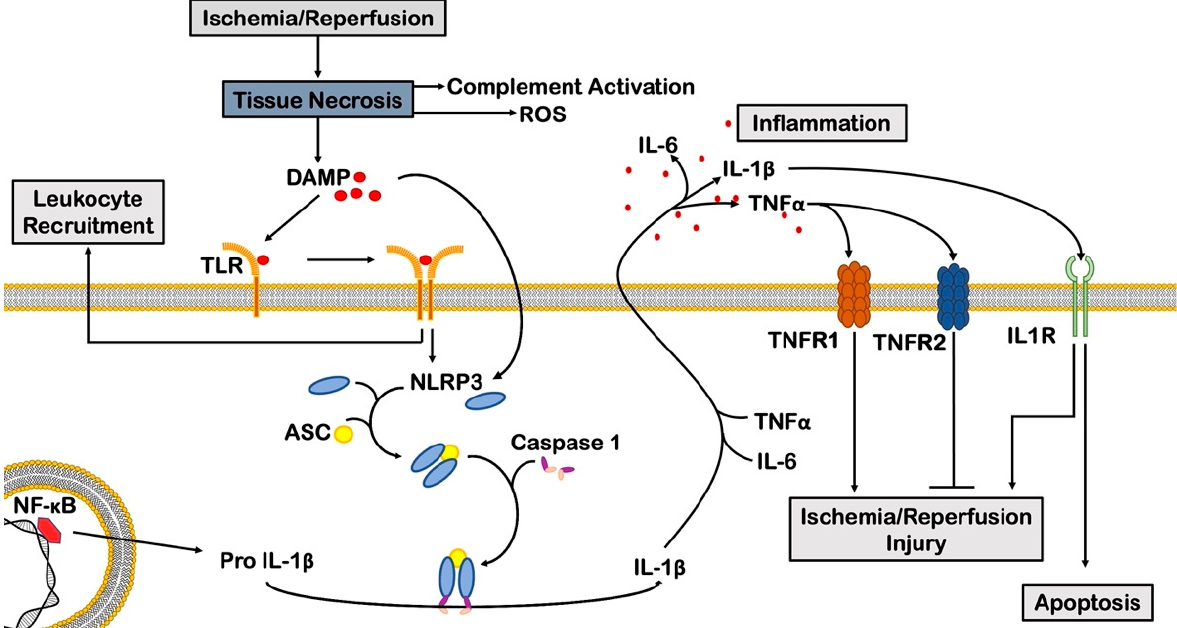
Figure 2. Schematic representation of the main signaling contributing to inflammation during myocardial ischemia. The inhibition of pro-inflammatory cytokines represents a useful therapeutic strategy to limit ischemic injury. ASC, apoptosis-associated speck-like protein containing a C-terminal caspase recruitment domain; DAMP, damage-associated molecular pattern; IL, interleukin; IL1R, interleukin 1 receptor; NF- κ B, nuclear factor kappa-light-chain-enhancer of activated B cells; NLRP3, Nod-like receptor (NLR) family pyrin domain containing 3; ROS, reactive oxygen species; TNF(R), tumor necrosis factor (receptor); TLR, Toll-like receptor. Downstream, the nucleotide-binding oligomerization domain-like receptor family pyrin domain containing 3 (NLRP3) inflammasome plays a central role in MI. The expres- sion of the components of this multimeric complex (e.g., NLRP3, apoptosis speck-like protein (ASC) and caspase-1) was found to be enhanced in preclinical models of acute myocardial ischemia and chronic MI and in patients who died from acute